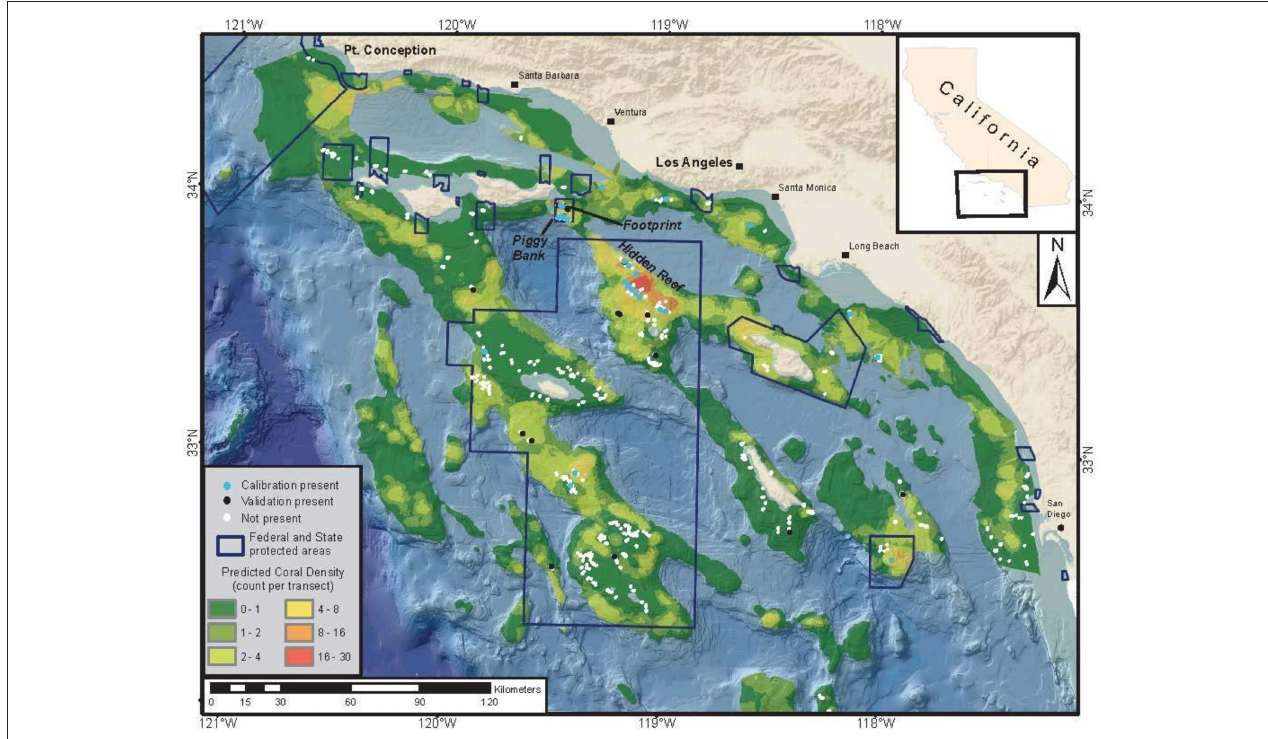
FIGURE 4 | Case Study 2: Southern California Bight. This map depicts coral density (coral colonies per transect group) estimated from a generalized additive model, presence and absence from a calibration dataset and from an independent dataset for Christmas tree corals, along with the boundaries of areas closed to fishing. Mean transect area = 740 m 2 . Figure reproduced with permission from Huff et al. (2013).